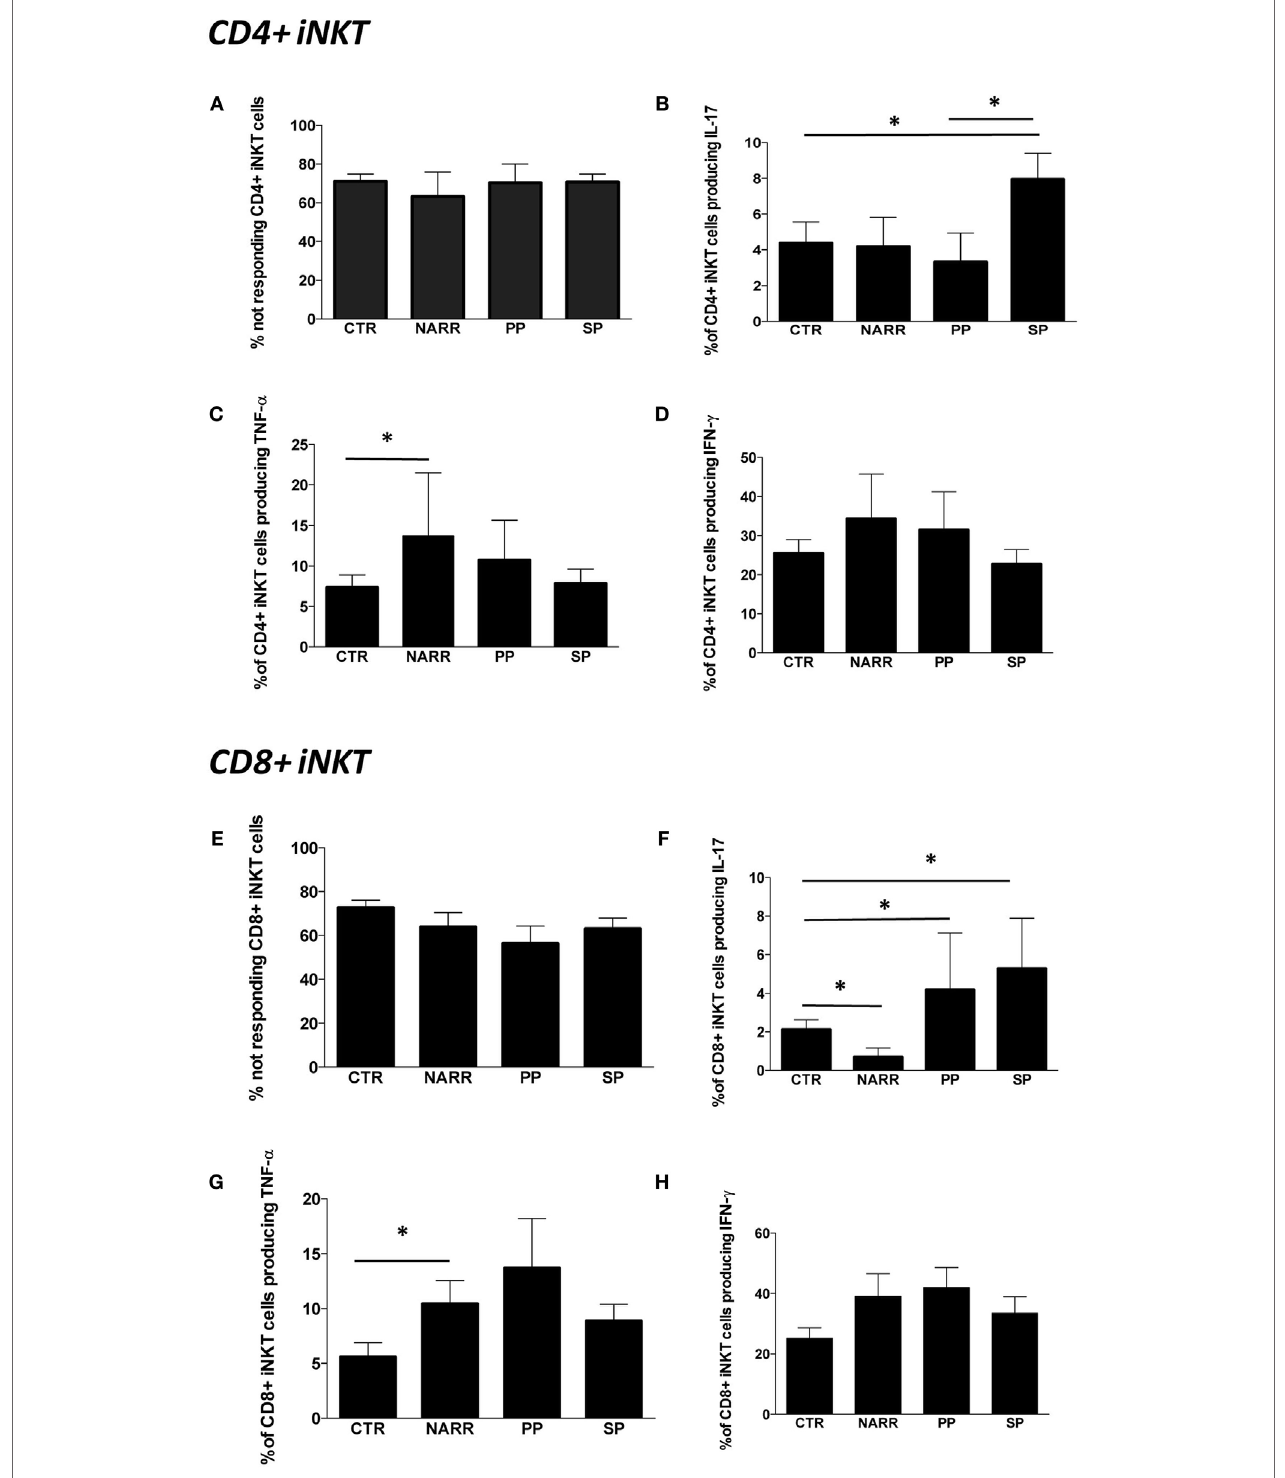
FigUre 4 | cytokine production by different subpopulations of inKT cells after stimulation . (a) Percentage of CD4 + iNKT cells that did not produce any cytokine after in vitro stimulation (not responding); (B) total IL-17 production by CD4 + iNKT cells; (c) total TNF- α production by CD4 + iNKT cells; (D) total IFN- γ production by CD4 + iNKT cells; (e) percentage of not responding CD8 + iNKT cells; (F) total IL-17 production by CD8 + iNKT cells; (g) total TNF- α production by CD8 + iNKT cells; (h) total IFN- γ production by CD8 + iNKT cells. The functional analysis was carried out on: 5 patients with not-active RR, 4 with PP, 12 with SP and 26 CTR. Bar graphs indicate mean ± SEM; * p <